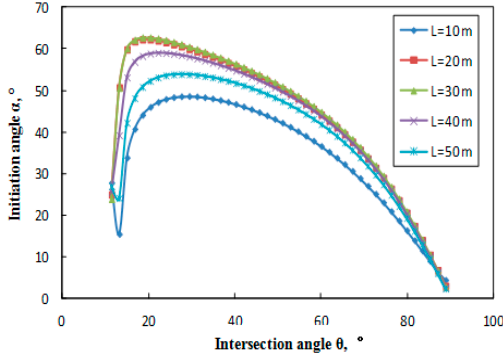
Figure 8. The impacts of distance of the fracture on the initiation angle.